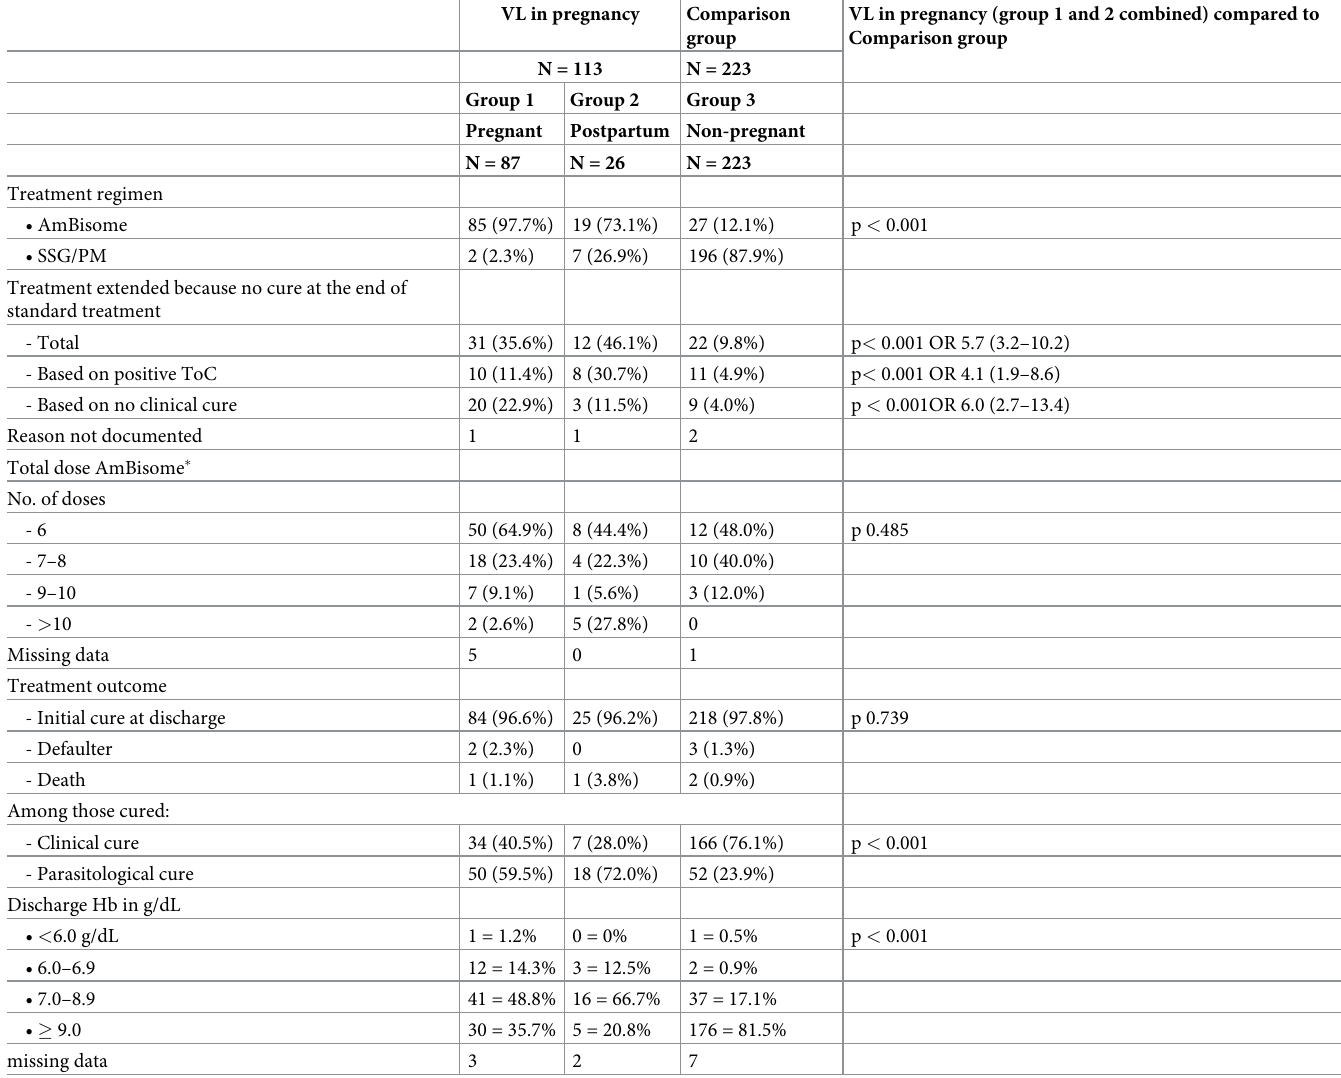
Table 3. Treatment